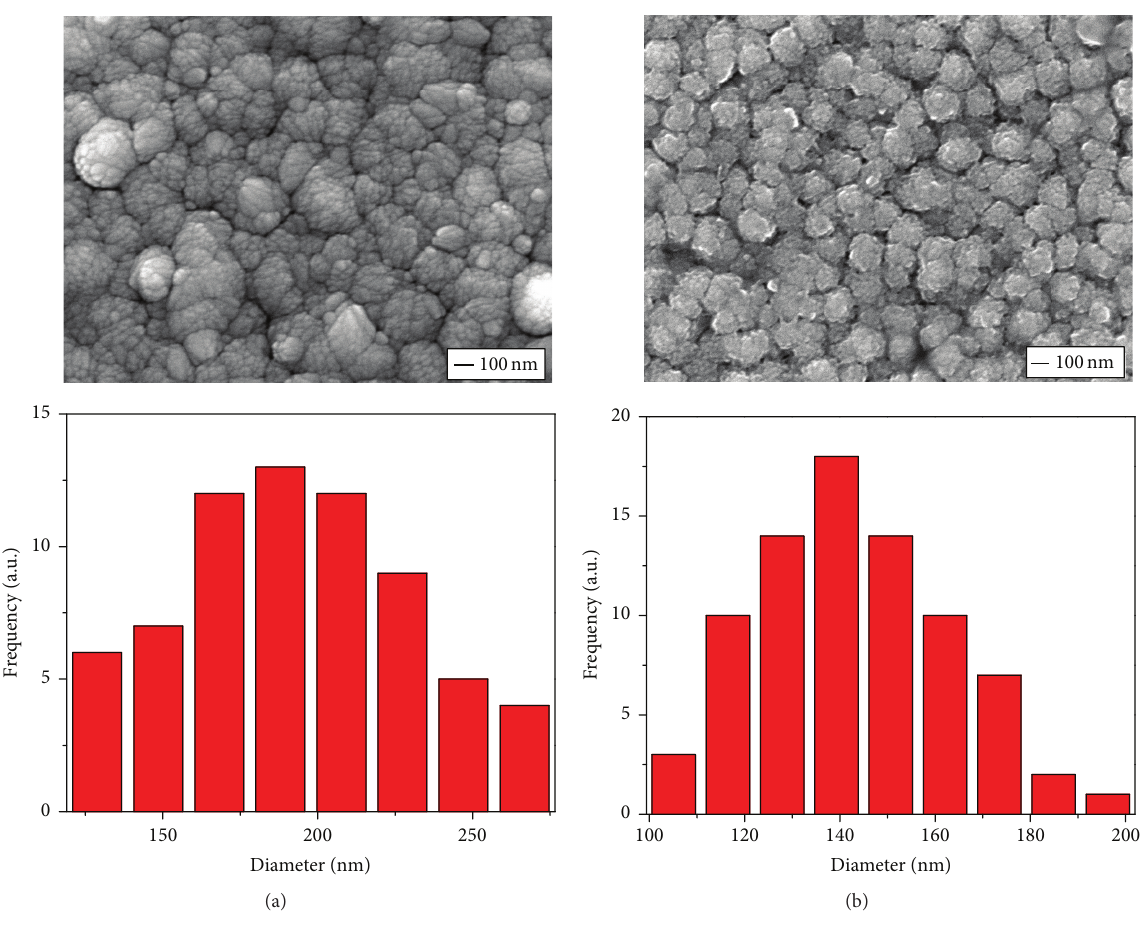
Figure 4: SEM micrographs of the ZnO-based thin films.